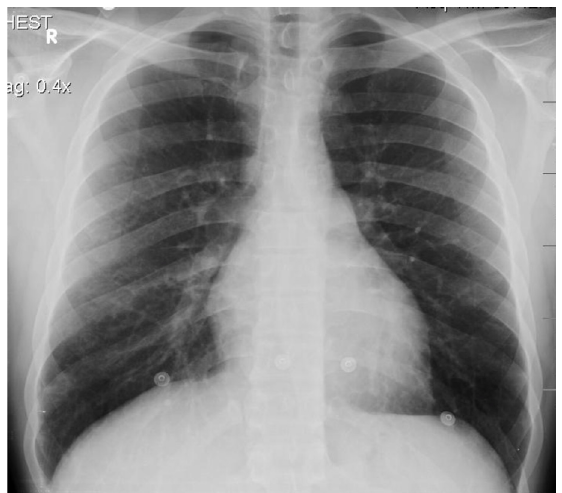
Figure 2. Repeat chest radiograph shows resolution of infiltrates and edema of Patient 1.